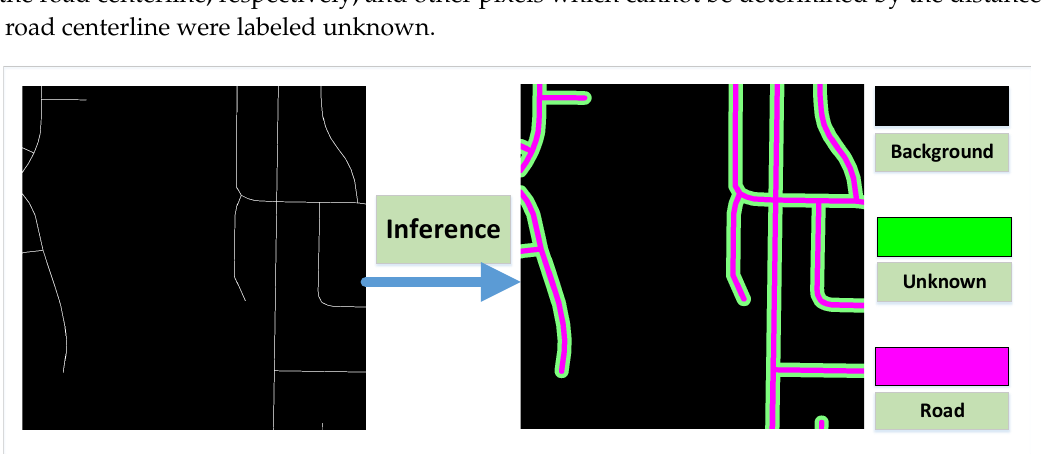
Figure 2. Initial road annotation